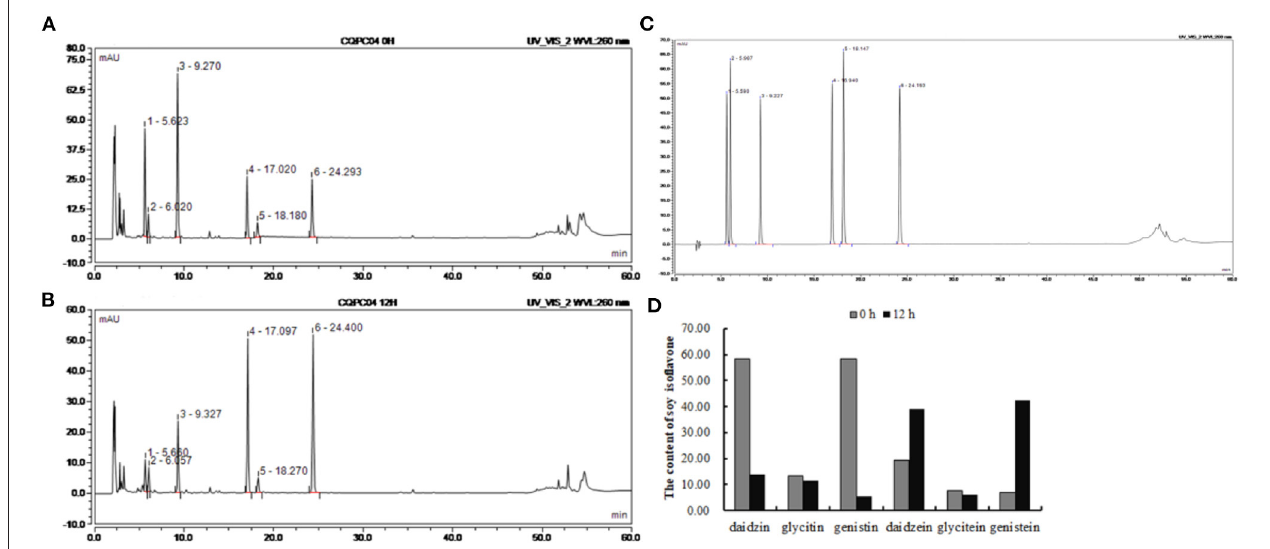
FIGURE 1 | Changes of soy isoflavone in soy milk before and after fermentation. (A) liquid chromatogram of non-fermented soy milk; (B) liquid chromatogram of L. fermentum CQPC04-fermented soy milk; (C) liquid chromatogram of standards; (D) soy isoflavone contents in non-fermented soy milk and L. fermentum CQPC04-fermented soy milk. 1: daidzin; 2: glycitin; 3: genistin; 4: daidzein; A; 5: glycitein; and 6: genistein.